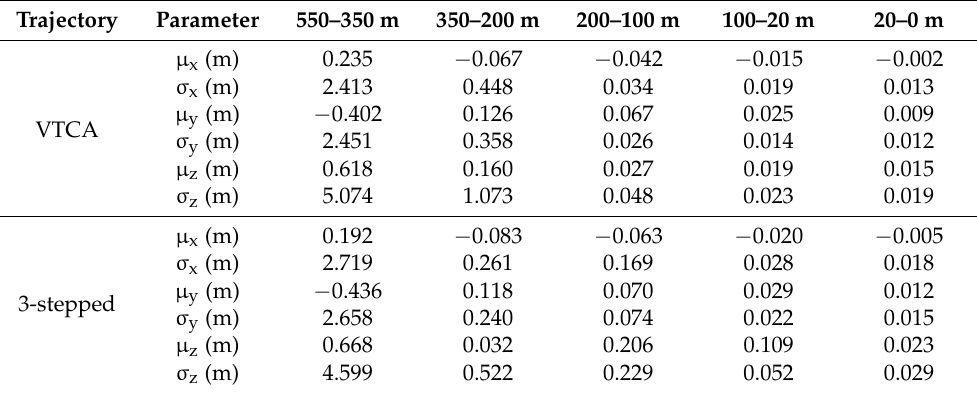
Table 5. Mean ( µ ) and standard deviation ( σ ) over 50 simulations of the EKF position estimates errors computed along different sections of the trajectories at night-time.